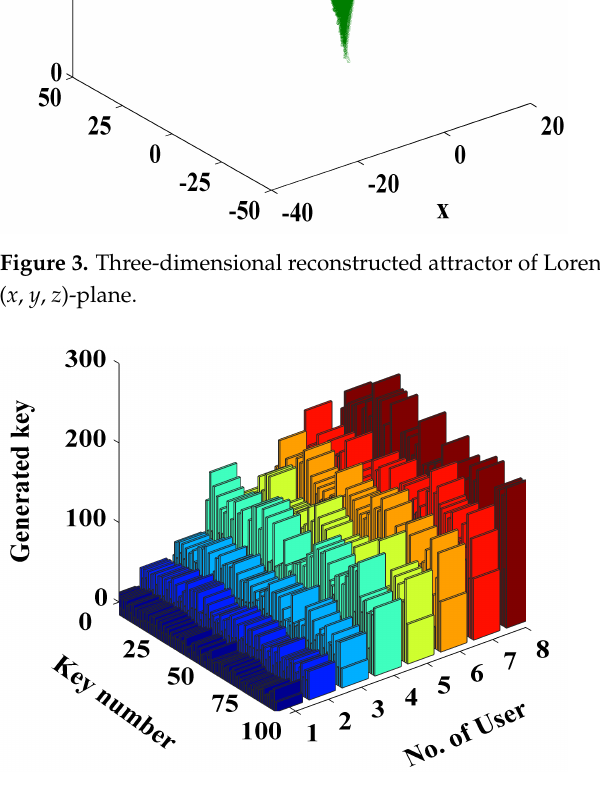
Figure 4. Generated keys for using Lorenz’s hyperchaos mapping system for different mMTC users.